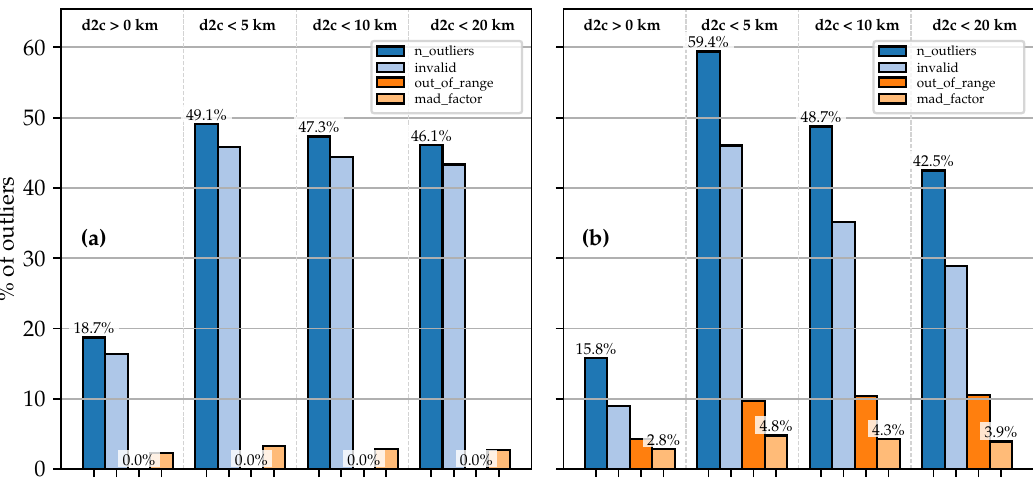
Figure 5. A comparison of outlier types as a function of dist2coast for the retrackers ( a ) SAMOSA and ( b )